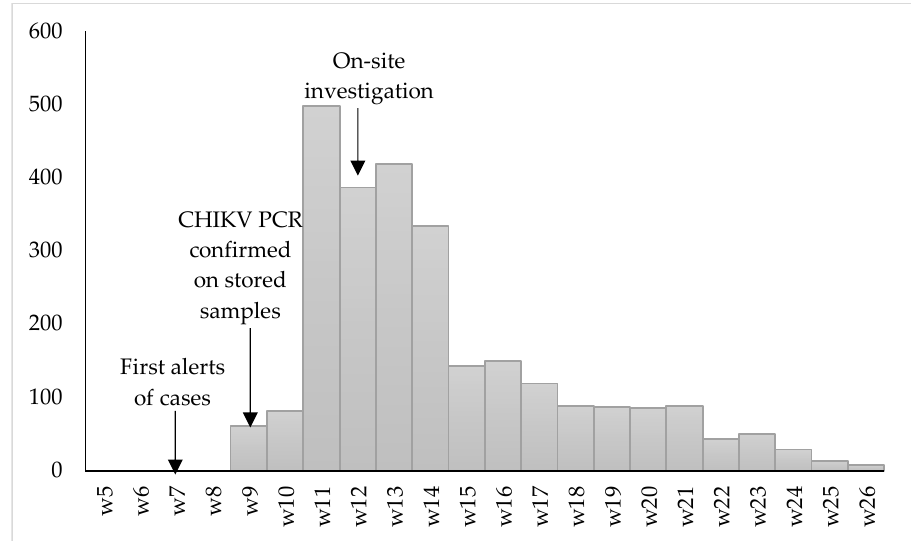
Figure 2. Epidemic curve based on weekly notification data of chikungunya fever suspected cases in Matadi health zone, by 2019 epi-weeks. Note: Chikungunya virus infections are not part of the diseases/syndromes of the national standard surveillance system in DRC. Notification was encouraged by the health authorities, but not obligatory, and was expected therefore to be incomplete.